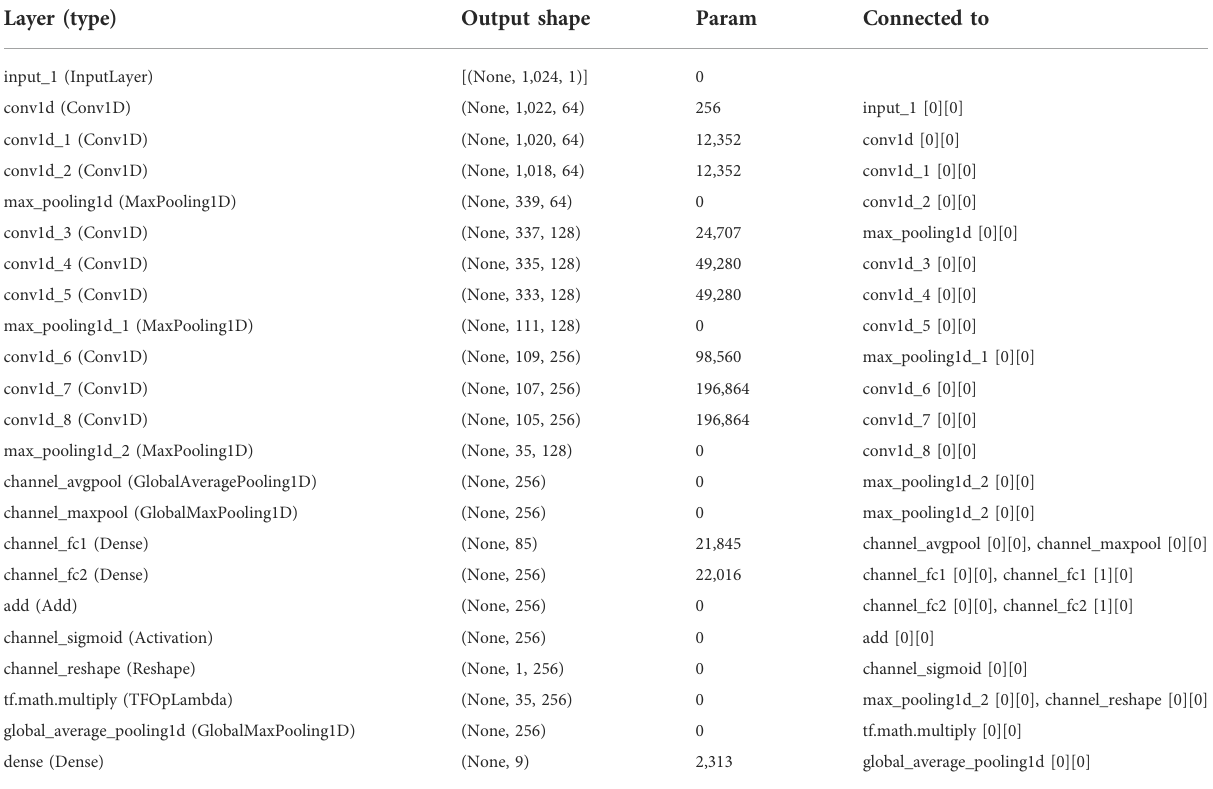
TABLE 2 Model summary of the CNN with channel attention